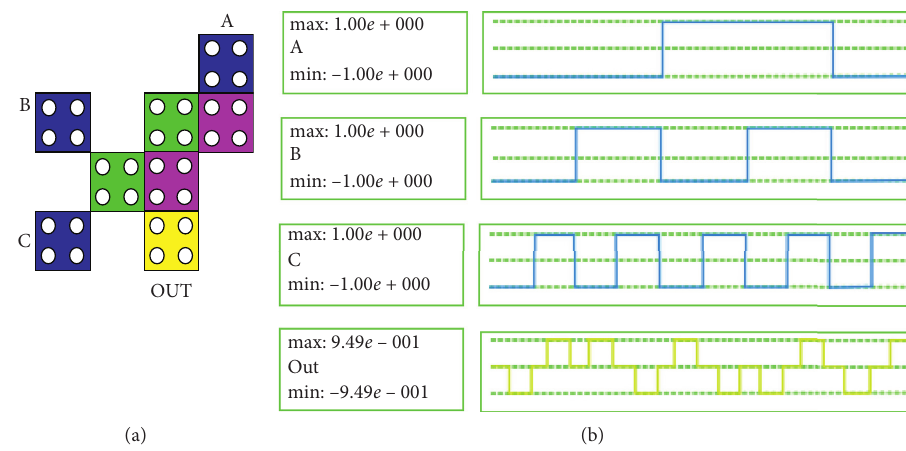
Figure 3: (a) The QCA layout of the proposed three-input XOR gate; (b) its simulation results.